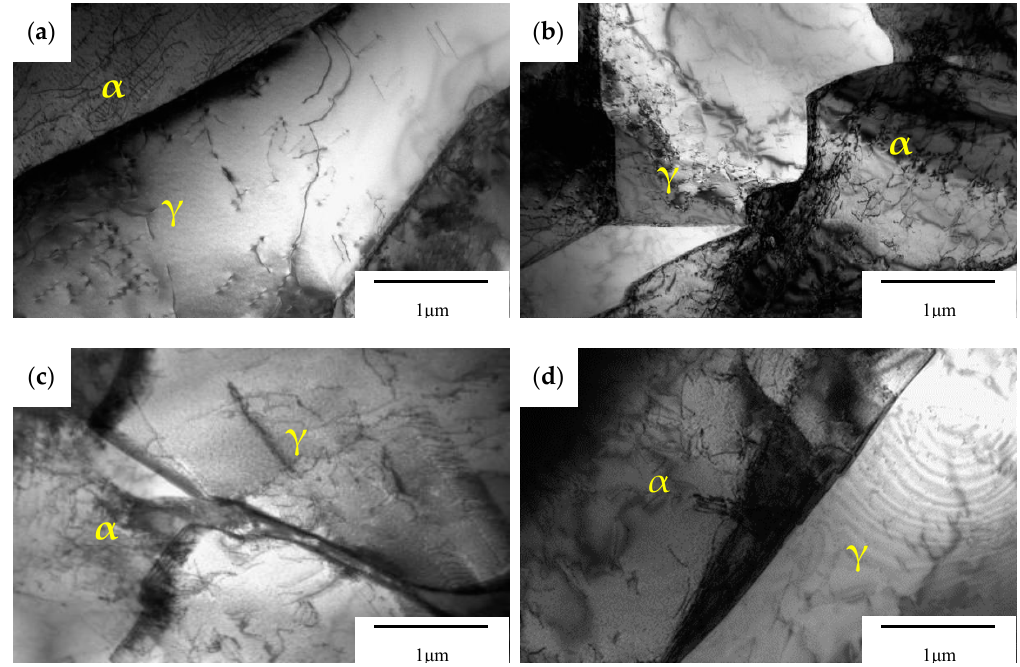
Figure 8. TEM-observed microstructure of DSS 2205 welded joints with different treatment methods: ( a ) untreated; ( b ) pneumatic chipping hammer; ( c ) ultrasonic peening treatment; ( d ) heat treatment.